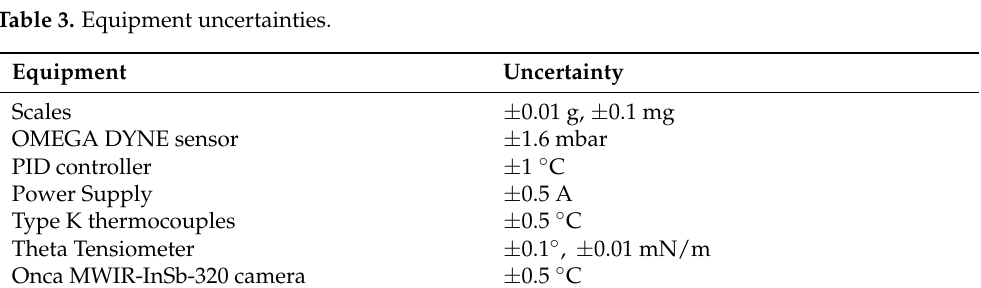
Table 3. Equipment